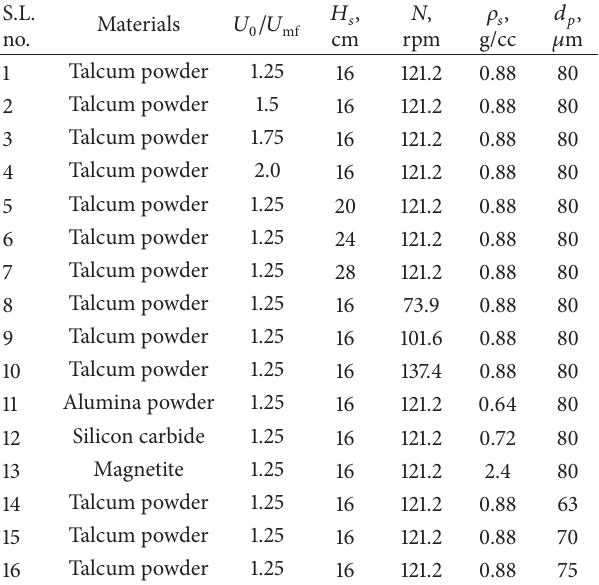
Table 1: Scope of the experiment for fine particles in fluidization